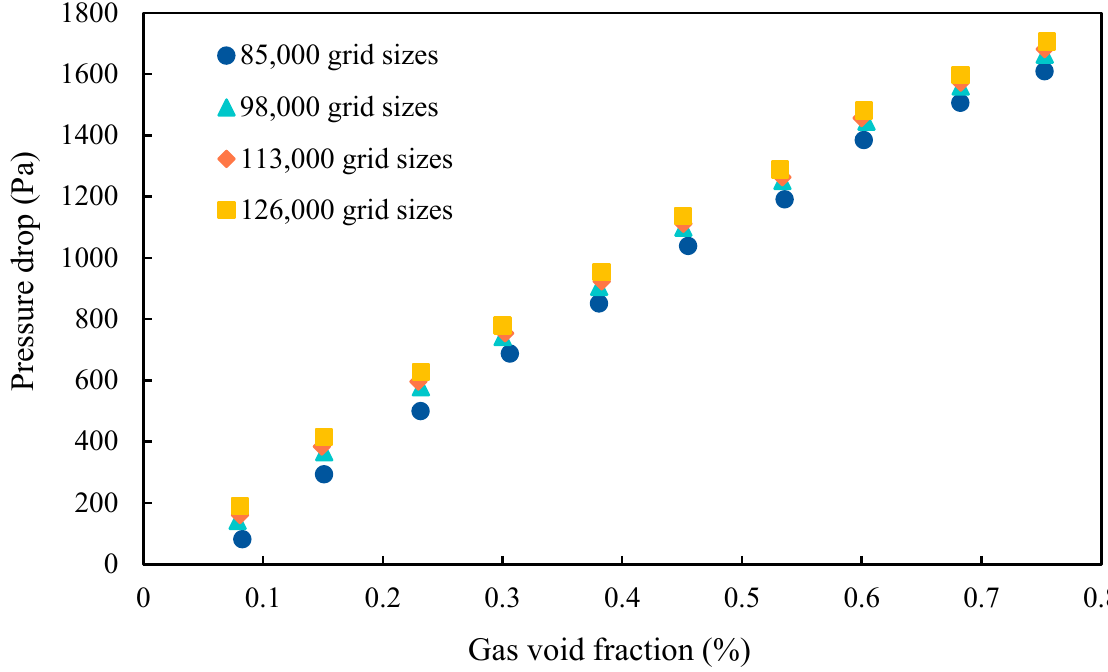
Figure 4. Simulated pressure drop along the tubing at four grid sizes.